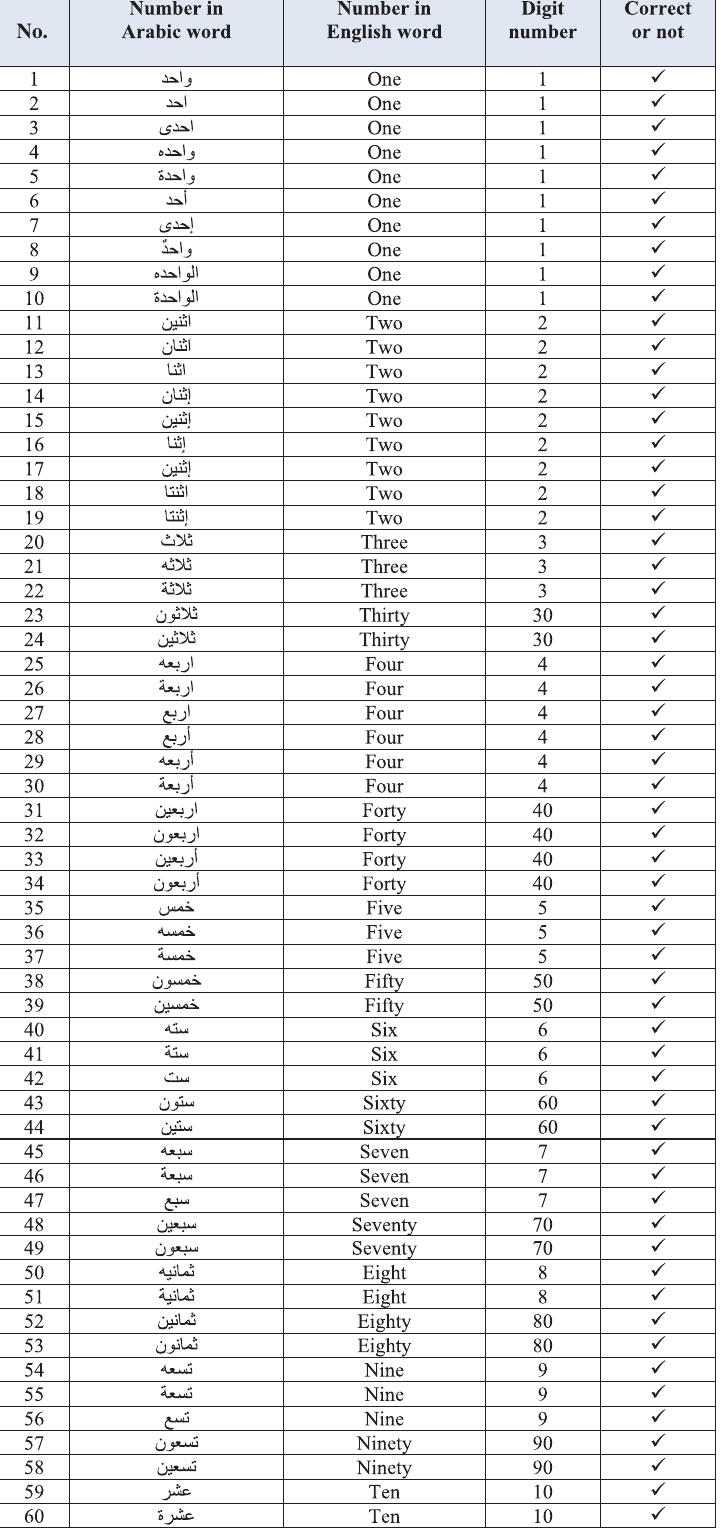
Table 2: The Results for Level of Word.